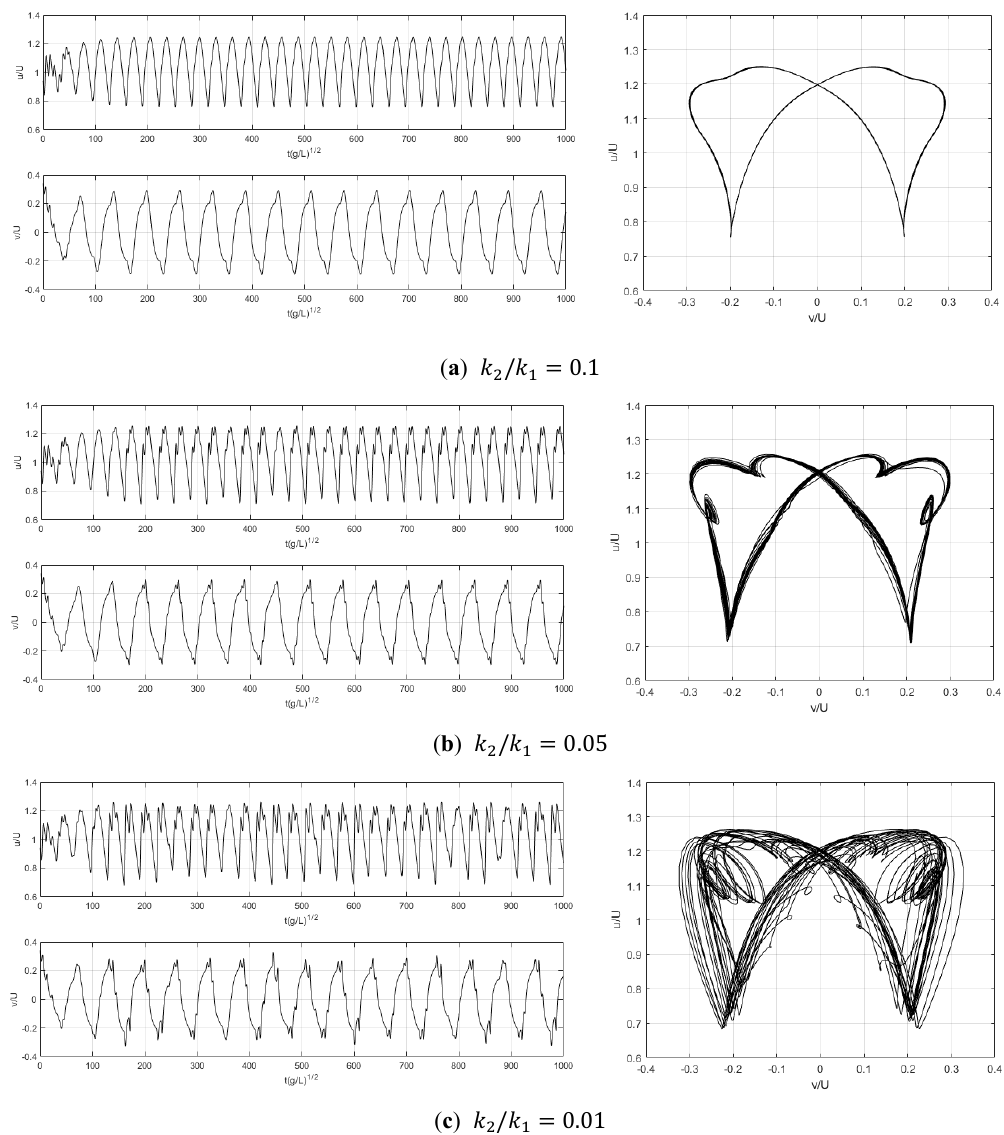
Figure 10. Time series and phase trajectories of the towed vessel with different bilinear towline models.